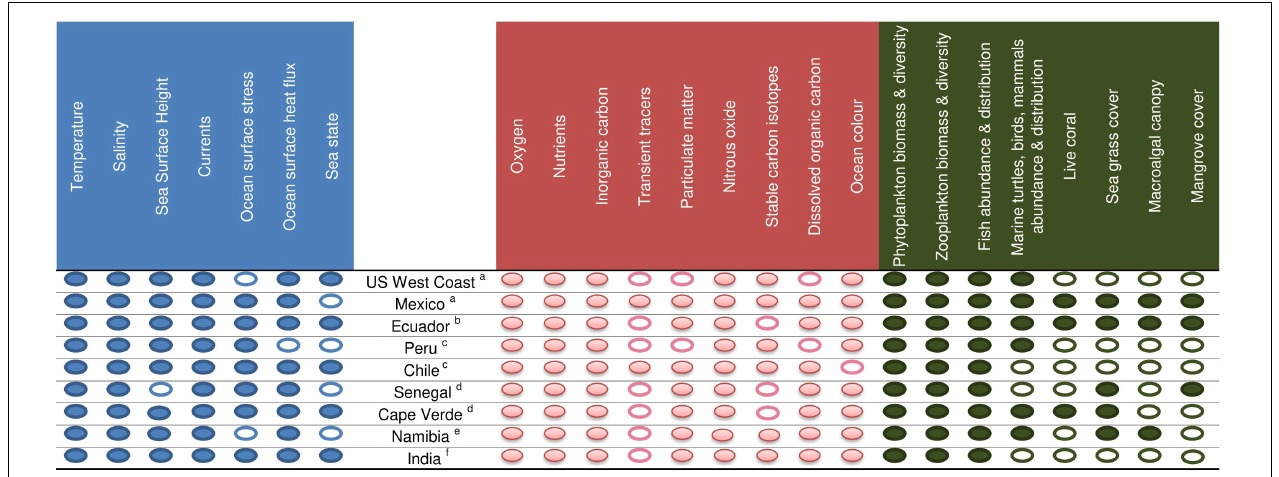
FIGURE 6 | Essential ocean variable observational requirements based on the questionnaire responses for each oxygen minimum zone (OMZ)-selected region.